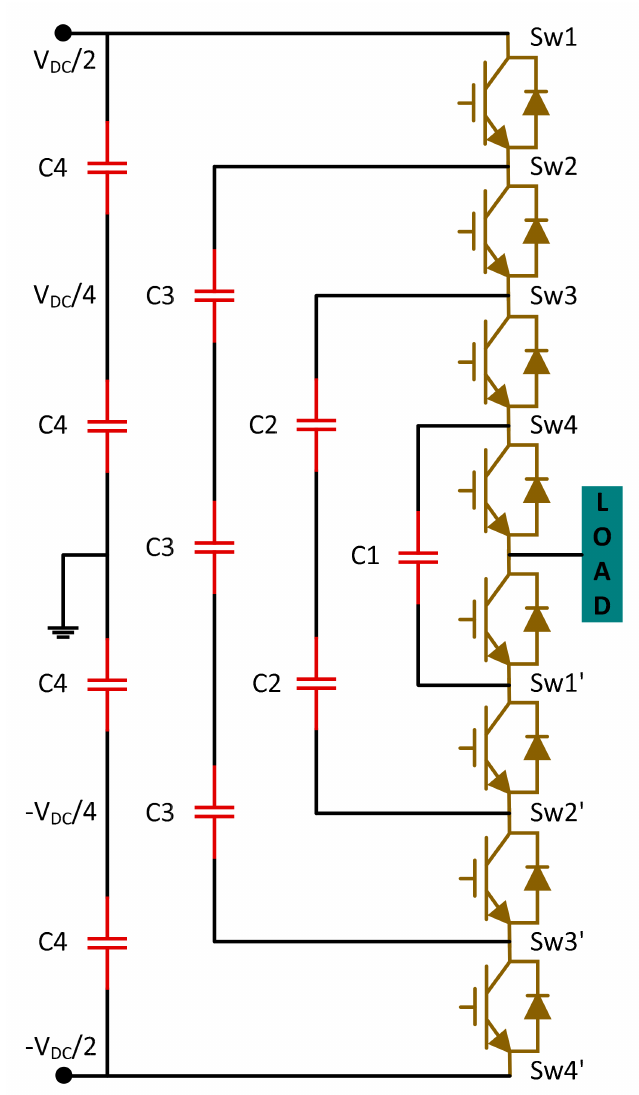
Figure 5. Topology of flying capacitor multilevel